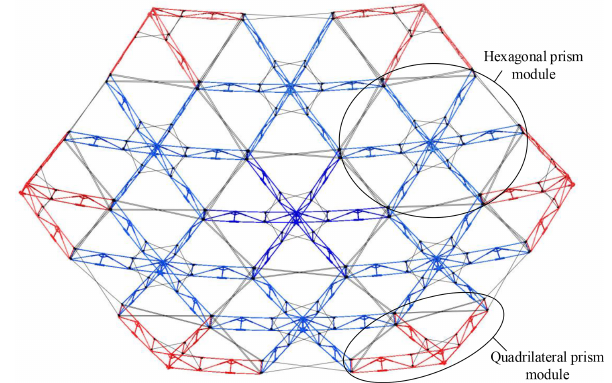
Figure 10. Overall structure of the deployable